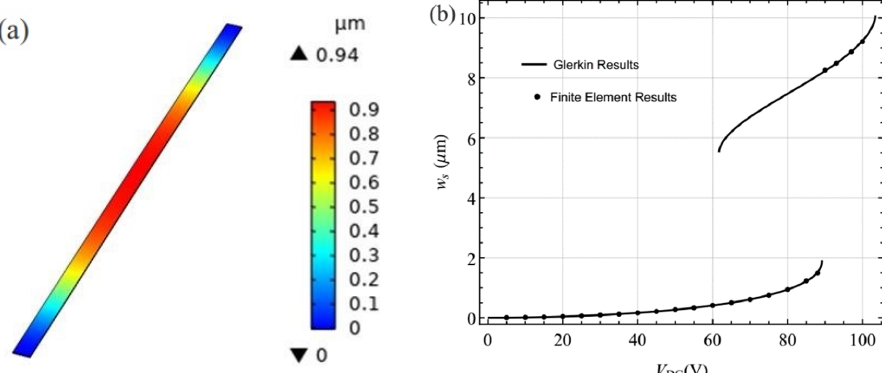
Figure 2. ( a ) The transverse deflection obtained using the software COMSOL when V DC = 80 V; ( b ) variations of the midpoint static deflection with the DC voltage.